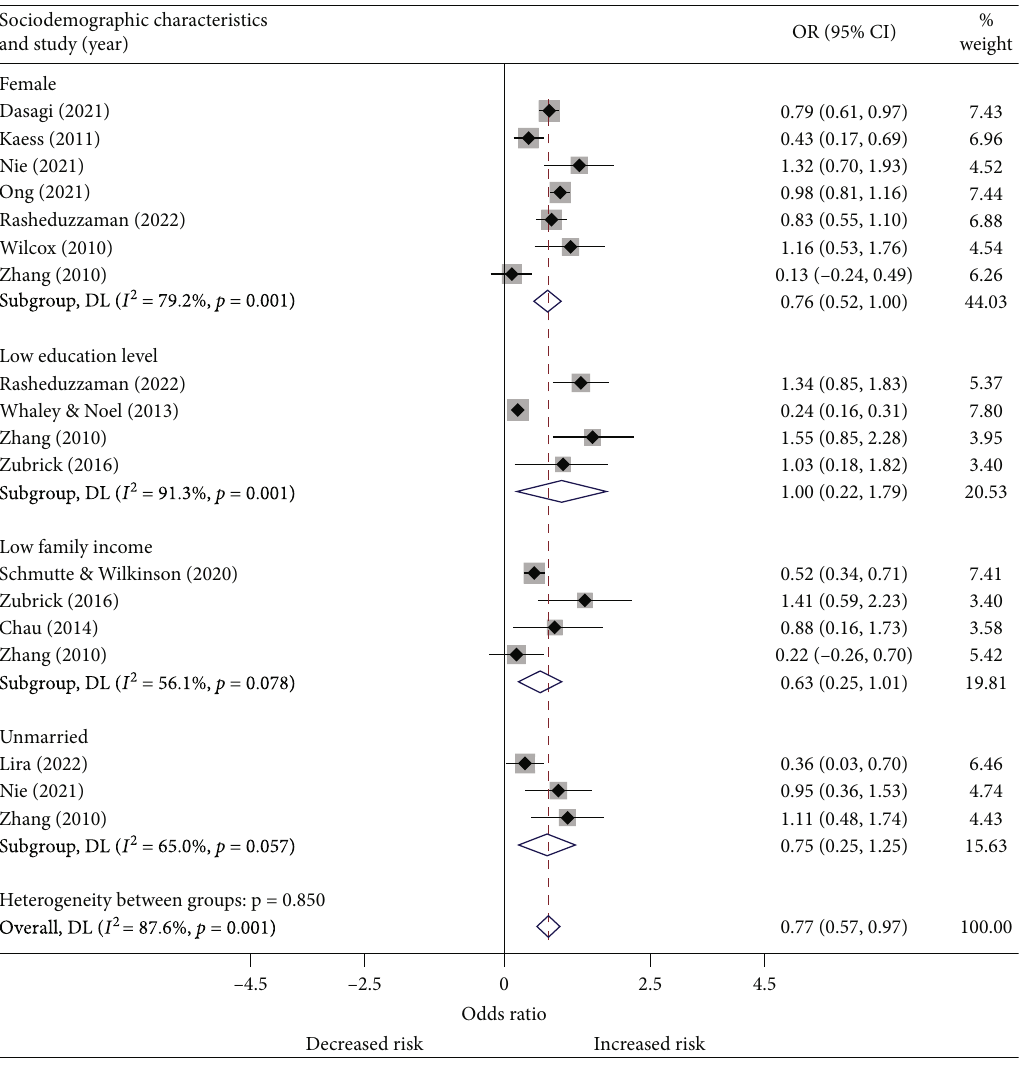
Figure 8: Sociodemographic characteristics as risk factors for suicide. Risk factors in this domain that are most strongly associated with suicide are being female and low education level. Table 3: Leading risk factors for suicide from each domain. OR (95%